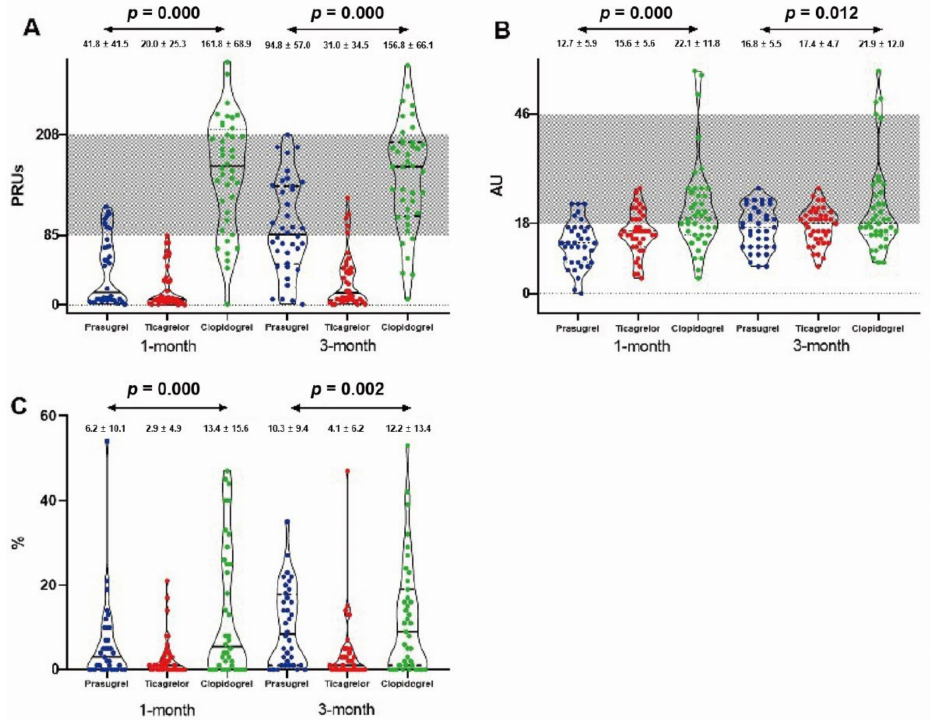
Figure 1. Differences in platelet aggregation inhibition between 1-month and 3-month periods as determined by three different assays (( A ): VerifyNow; ( B ): MEA; ( C ): LTA). Dotted area represents OPR. PRUs: P2Y12 reaction units; AU: aggregation units; OPR: optimal platelet reactivity. At one month, OPR rates were markedly lower with both prasugrel and ticagrelor compared to clopidogrel as determined by VN (21.1%:0.0%:57.5%; p = 0.001); OPR